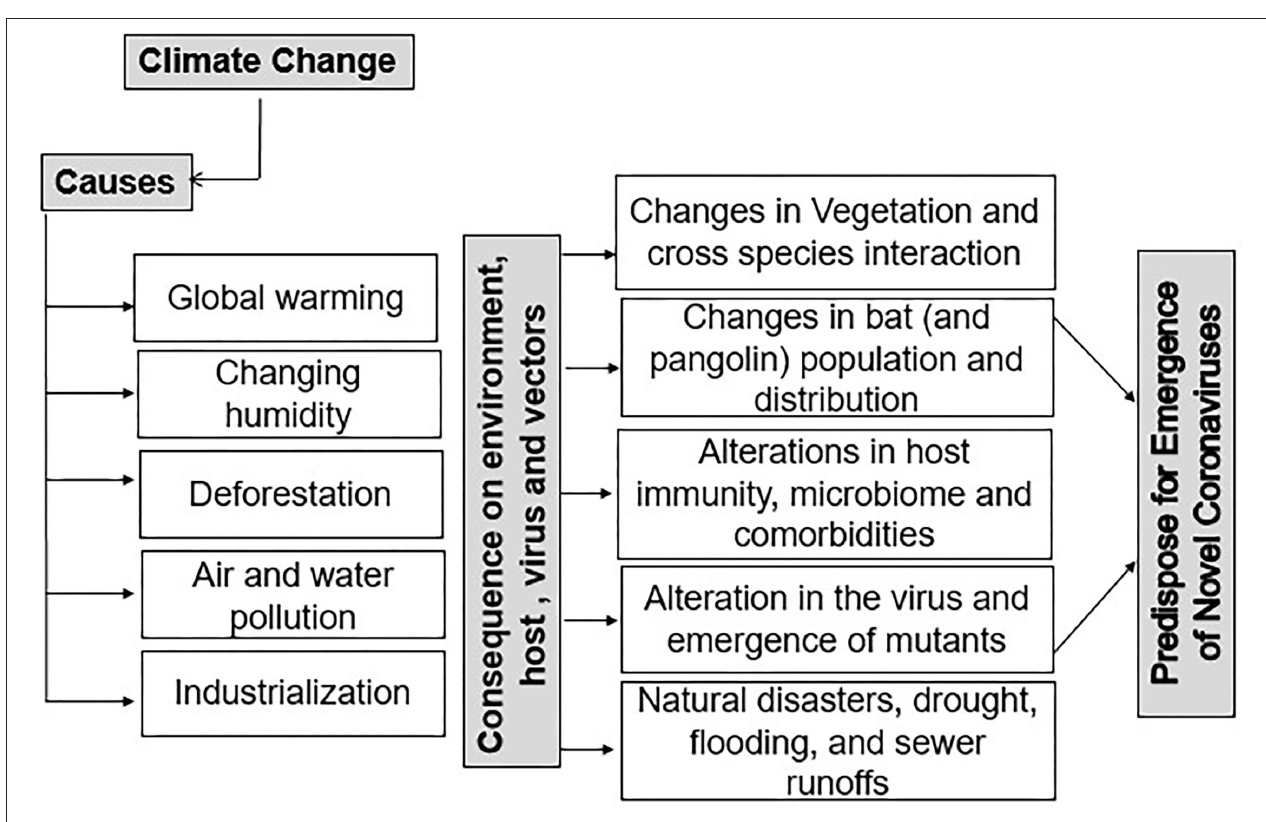
FIGURE 1 | Climatic change as a driver for the emergence of novel coronaviruses. Changes in different climatic parameters such as temperature and humidity are shown to impact the emergence of novel coronaviruses by altering the host, vectors, and the virus itself. Changing climate has significantly affected the habitat distribution of vectors and carriers (i.e., bat and pangolin populations). Changes in construction, deforestation, frequent natural calamities, and an increase in air pollution have also affected host immunity, virus transmission efficiency, and cross-species interactions and have contributed to the emergence of novel